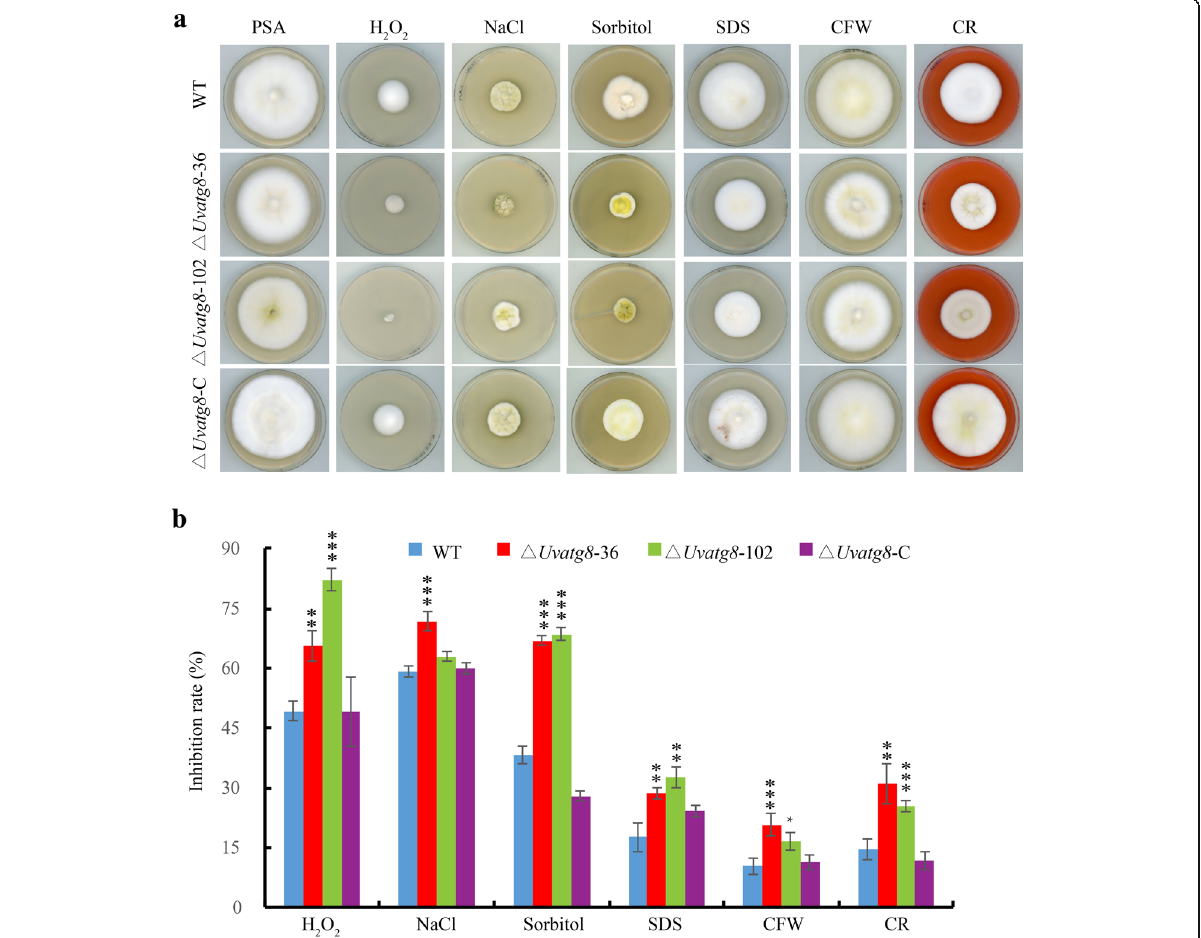
Fig. 5 Defects of the Δ Uvatg8 mutants in response to different stresses. a, The represent strains were cultured on regular PSA plates or PSA plates with 0.03% H 2 0 2 , 0.4 M NaCl, 0.7 M sorbitol, 0.03% Sodium dodecyl sulfate (SDS), 200 μ g/mL Calcofluor white (CFW), 240 μ g/mL Congo red (CR) plates. Typical cultures were photographed after incubation for 15 d at 28 °C. b, Statistical analysis of inhibition rate of test strains under different stress conditions. The diameters of colonies were detected and analyzed. Similar results were obtained by three repeated experiments. The error bars represent the standard deviation and the asterisk represents the significant difference compared to the WT strain under the same conditions (*, p < 0.01; **, p < 0.005; ***, p <